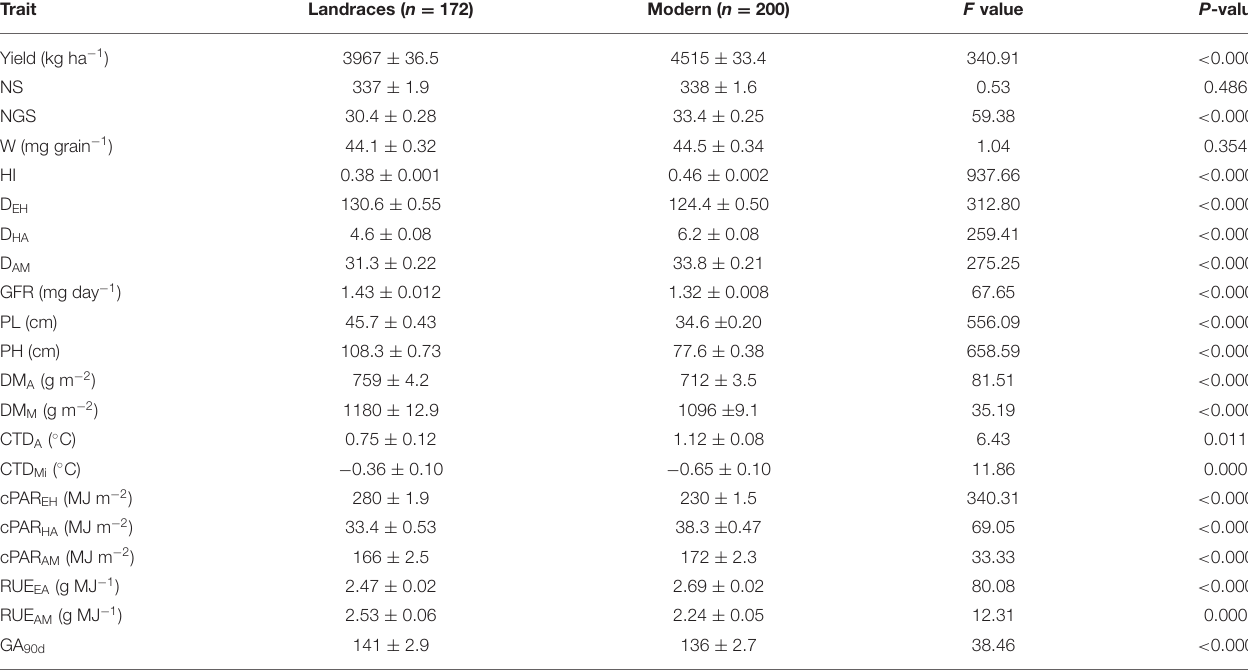
TABLE 1 | Analyses of variance and mean values ± SE for agronomic traits of a panel of durum wheat Mediterranean landraces and modern cultivars of diverse origin.